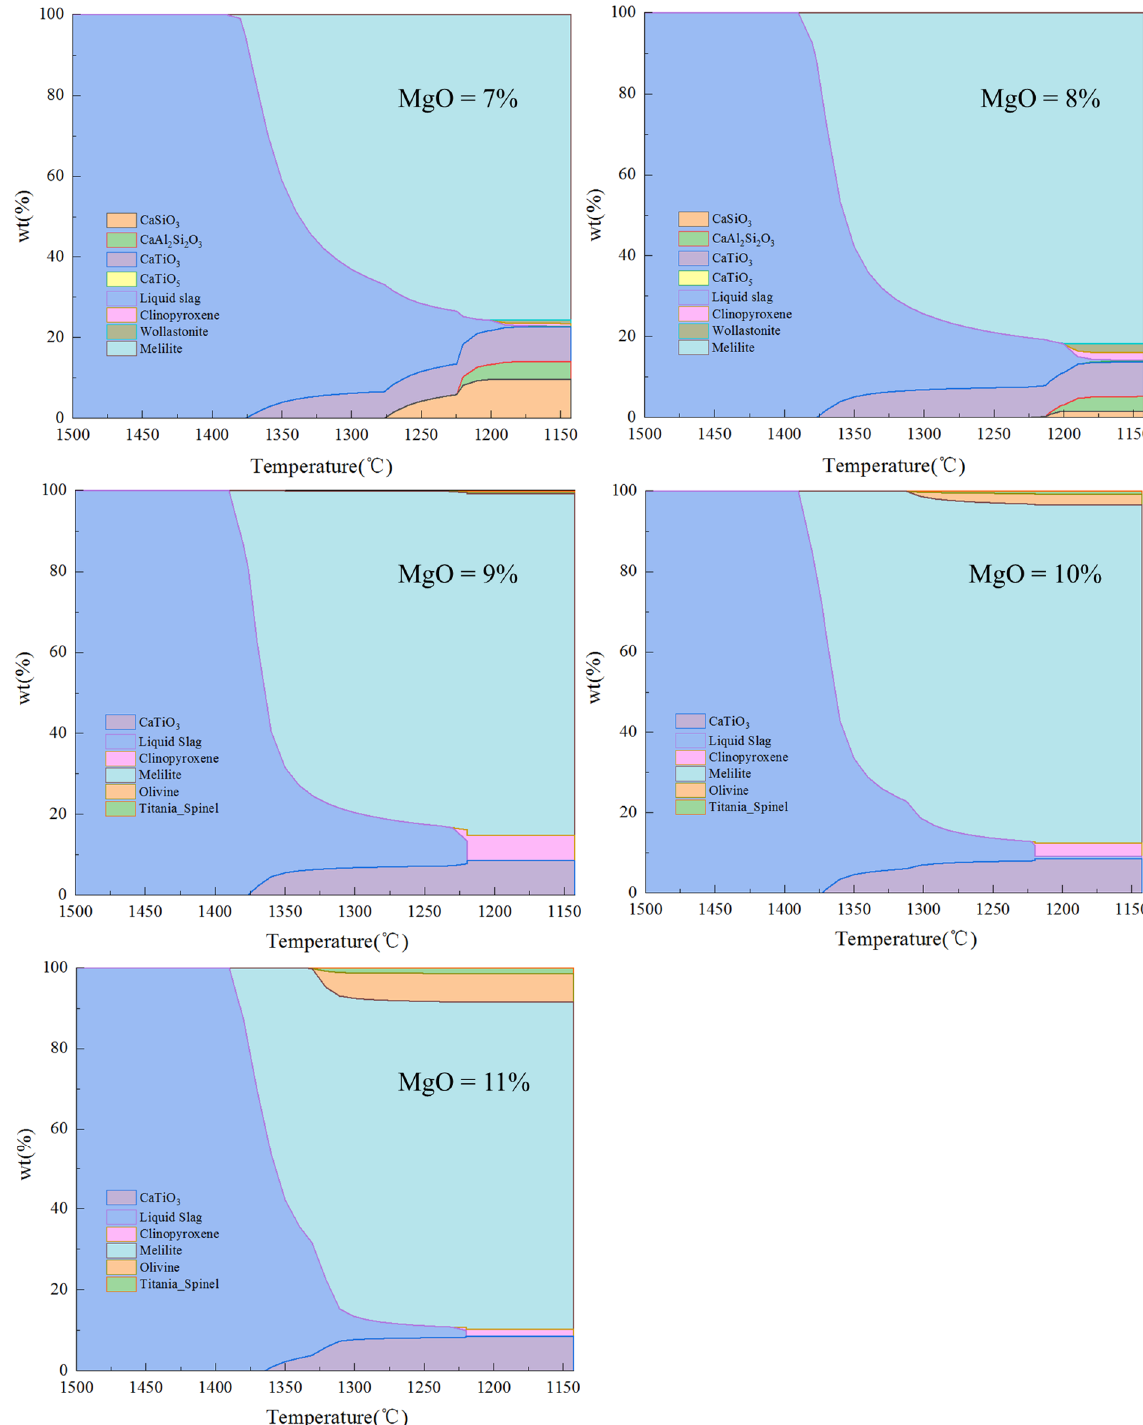
Figure 7. Crystallization of CaO-SiO 2 -Al 2 O 3 -MgO-TiO 2 with different MgO contents. XRD, SEM, and EDS analyses are used to define the differences in phase and micro- morphology of the BF slag with different contents of MgO. Figure 8 presents the phase